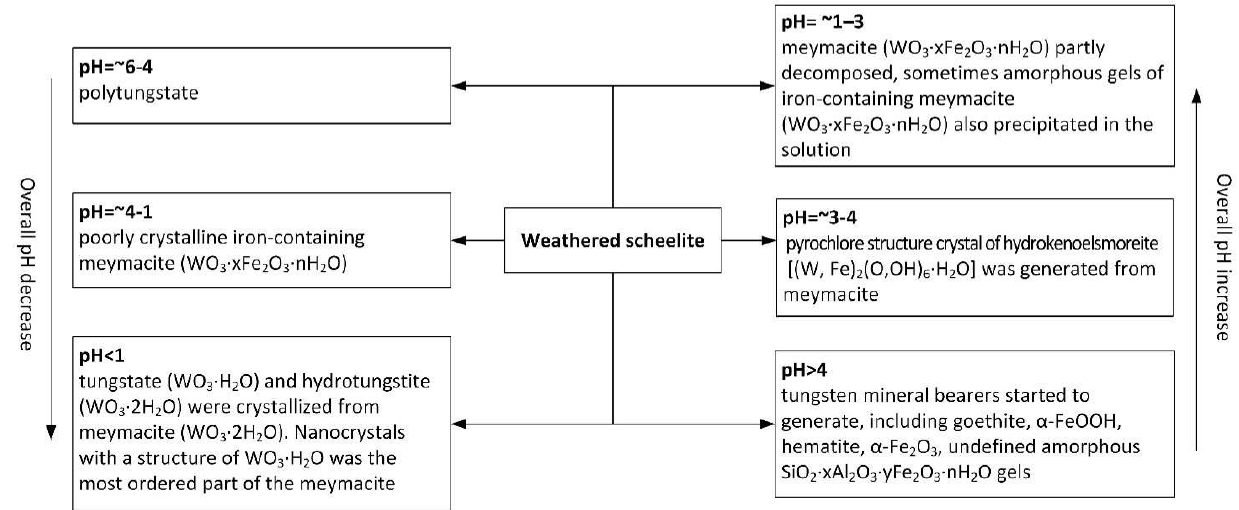
Figure 2. Secondary minerals of scheelite under different overall pH of supergene solutions in the oxidation zone of the Grantcharitsa scheelite deposit in Bulgaria. Based on: [23].